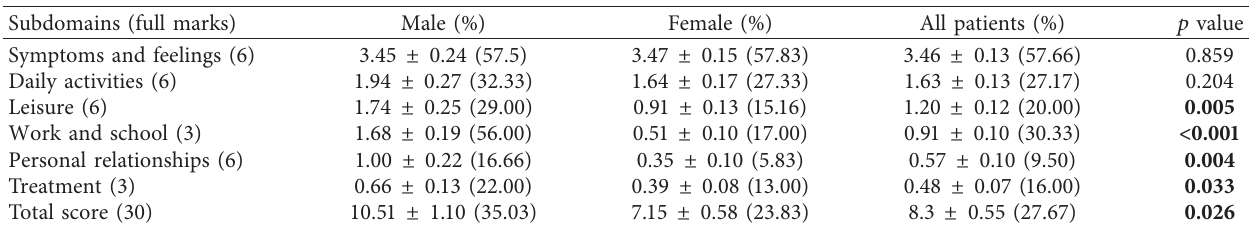
Table 2: The mean score ± standard error by the subdomains of the DLQI in patients with chronic urticaria.